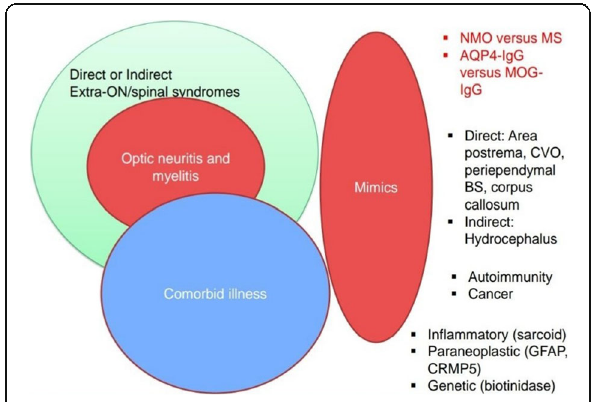
Fig. 3 Mimics of neuromyelitis optica spectrum disorders [16]. AQP4-IgG aquapurine-4 immunoglobulin G, ON optic neuritis, CVO circum ventricular organ, BS brain stem, MS multiple sclerosis, NMO neuromyelitis optica, MOG-IgG myelin oligodendrocyte glycoprotein, GFAP glial fibrillary acidic protein, CRM5 collapsin response-mediator